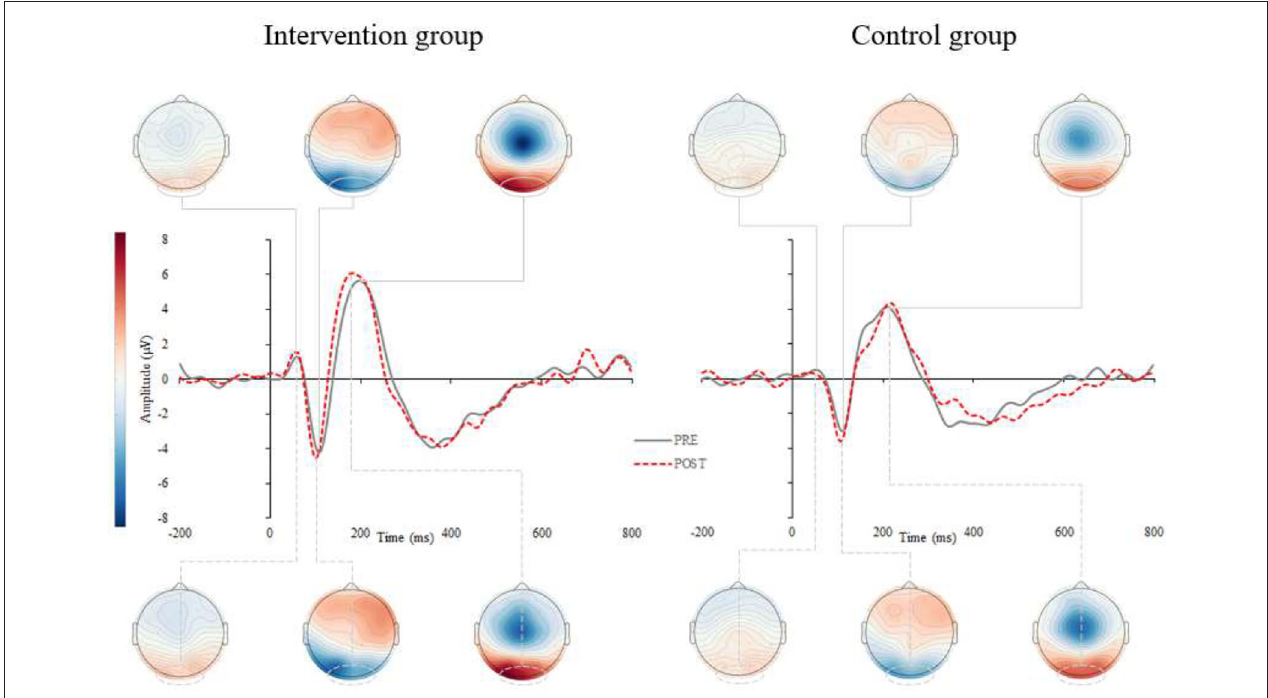
FIGURE 2 | Grand average stimulus-locked event-related potentials (s-ERPs) for the intervention (left) and control (right) group. Figure represents the grand averaged ERPs for pre- (gray, solid) and post-assessments (red, dashed) for intervention (left) and control group (right). The s-ERPs correspond to occipital electrodes (averaged across O1, Oz, and O2) and show visual components P1, N1 and P2 after the visual stimuli occurrence.